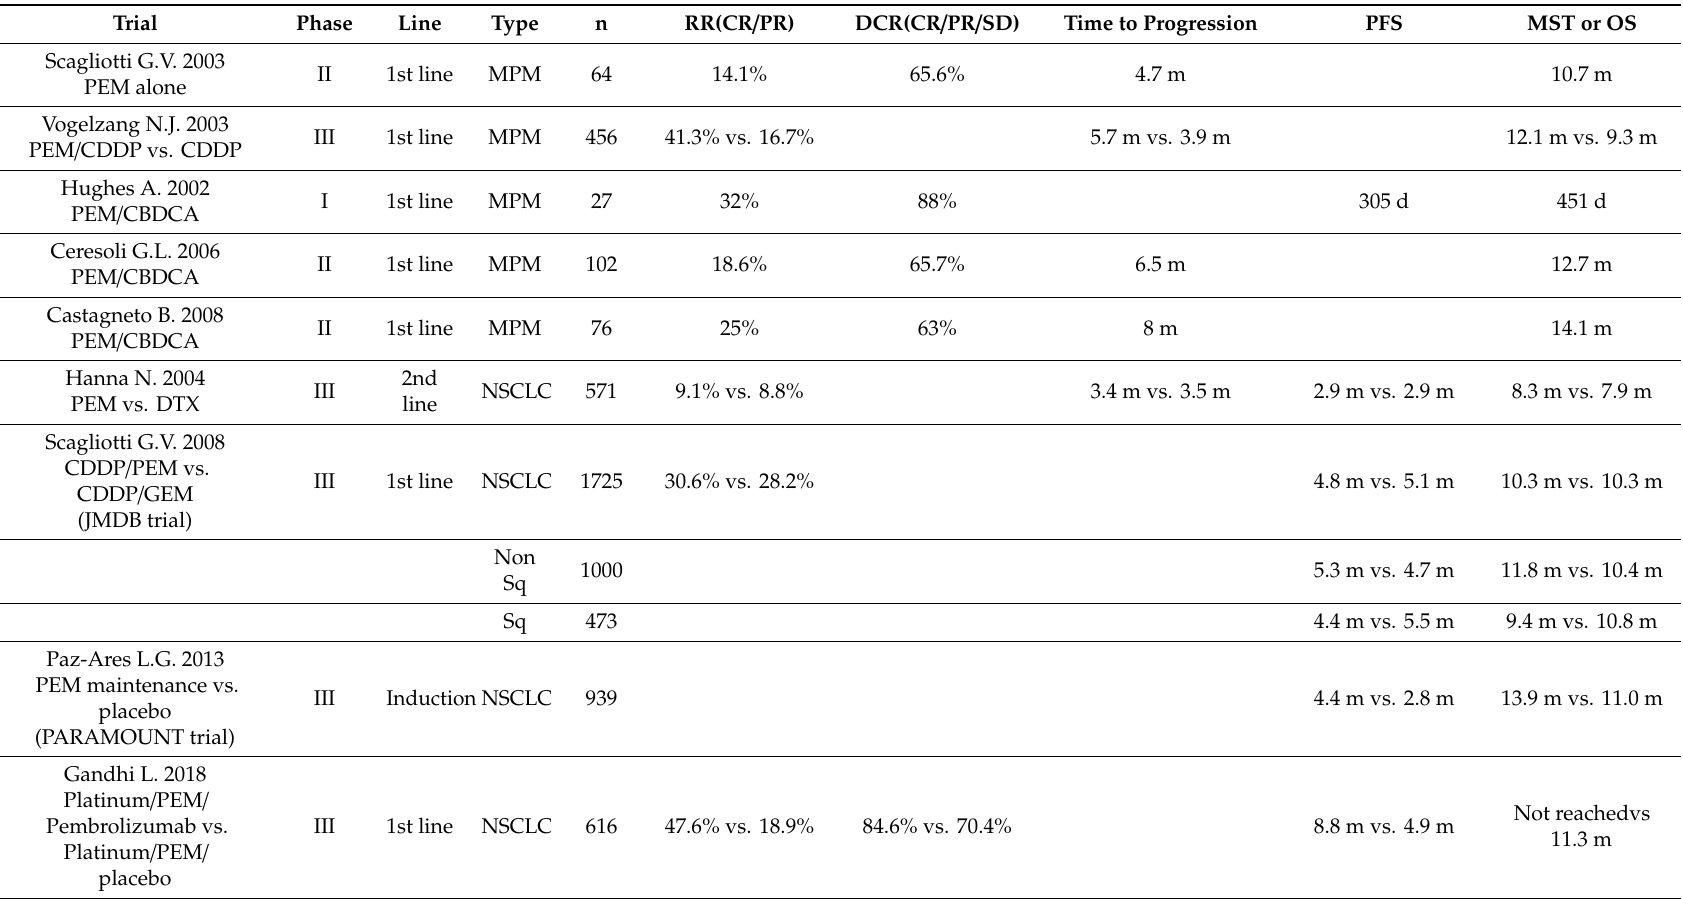
Table 1. Results of clinical trials of